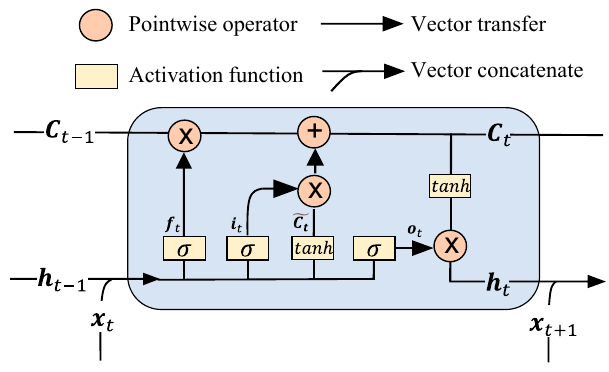
Figure 3. The structure of the LSTM memory cell.